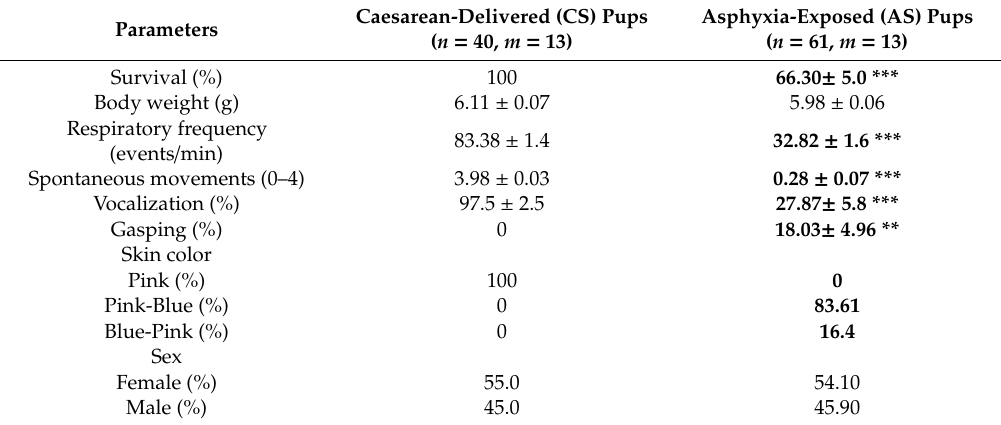
Table 1. Apgar scale evaluation. Data are expressed as means ± SEM. n , number of pups; m , number of dams. The e ff ect of perinatal asphyxia (PA) was evaluated on (i) survival ( Mann Whitney test U = 1220, *** p < 0.0001); (ii) body weight (g; n.s.); respiratory frequency (events / min) ( Mann Whitney test U = 0.50, p < 0.0001); (iii) spontaneous movement (0–4; 0 = no movements; 4 = coordinated movements of fore and hindlimbs, as well as head and neck) ( Mann Whitney test U = 0, *** p < 0.0001); (iv) vocalization % (yes / no) ( Mann Whitney test U = 370, p < 0.0001); (v) gasping (yes / no) ( Mann Whitney test U = 1000; ** p < 0.005); color of skin (% pink, pink blue, or blue pink). * Comparisons with respect to controls (Bold); n.s., no statistically significant di ff